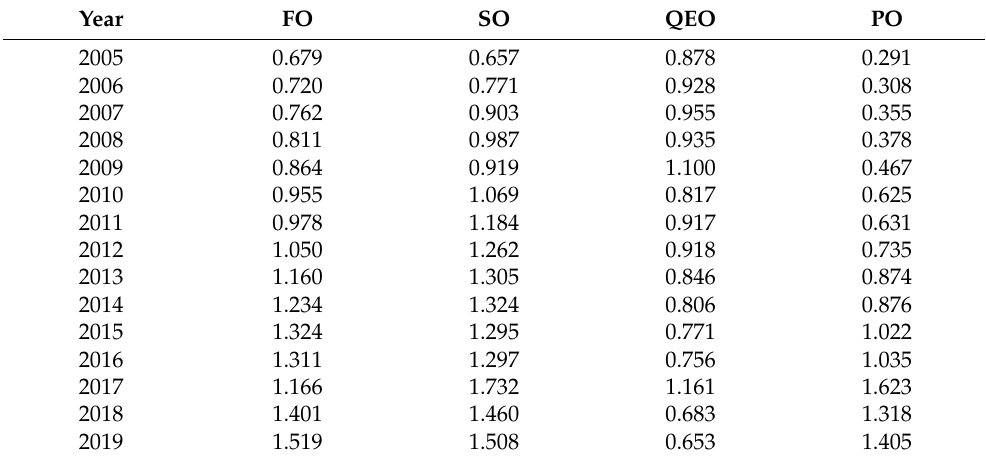
Table 4. The development level of the subsystems of the open economy in YRDA from 2005 to 2019.